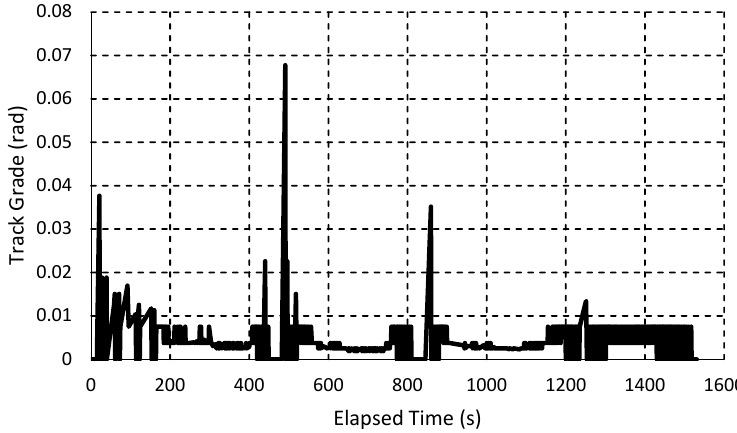
Figure 4. Normalized time variant